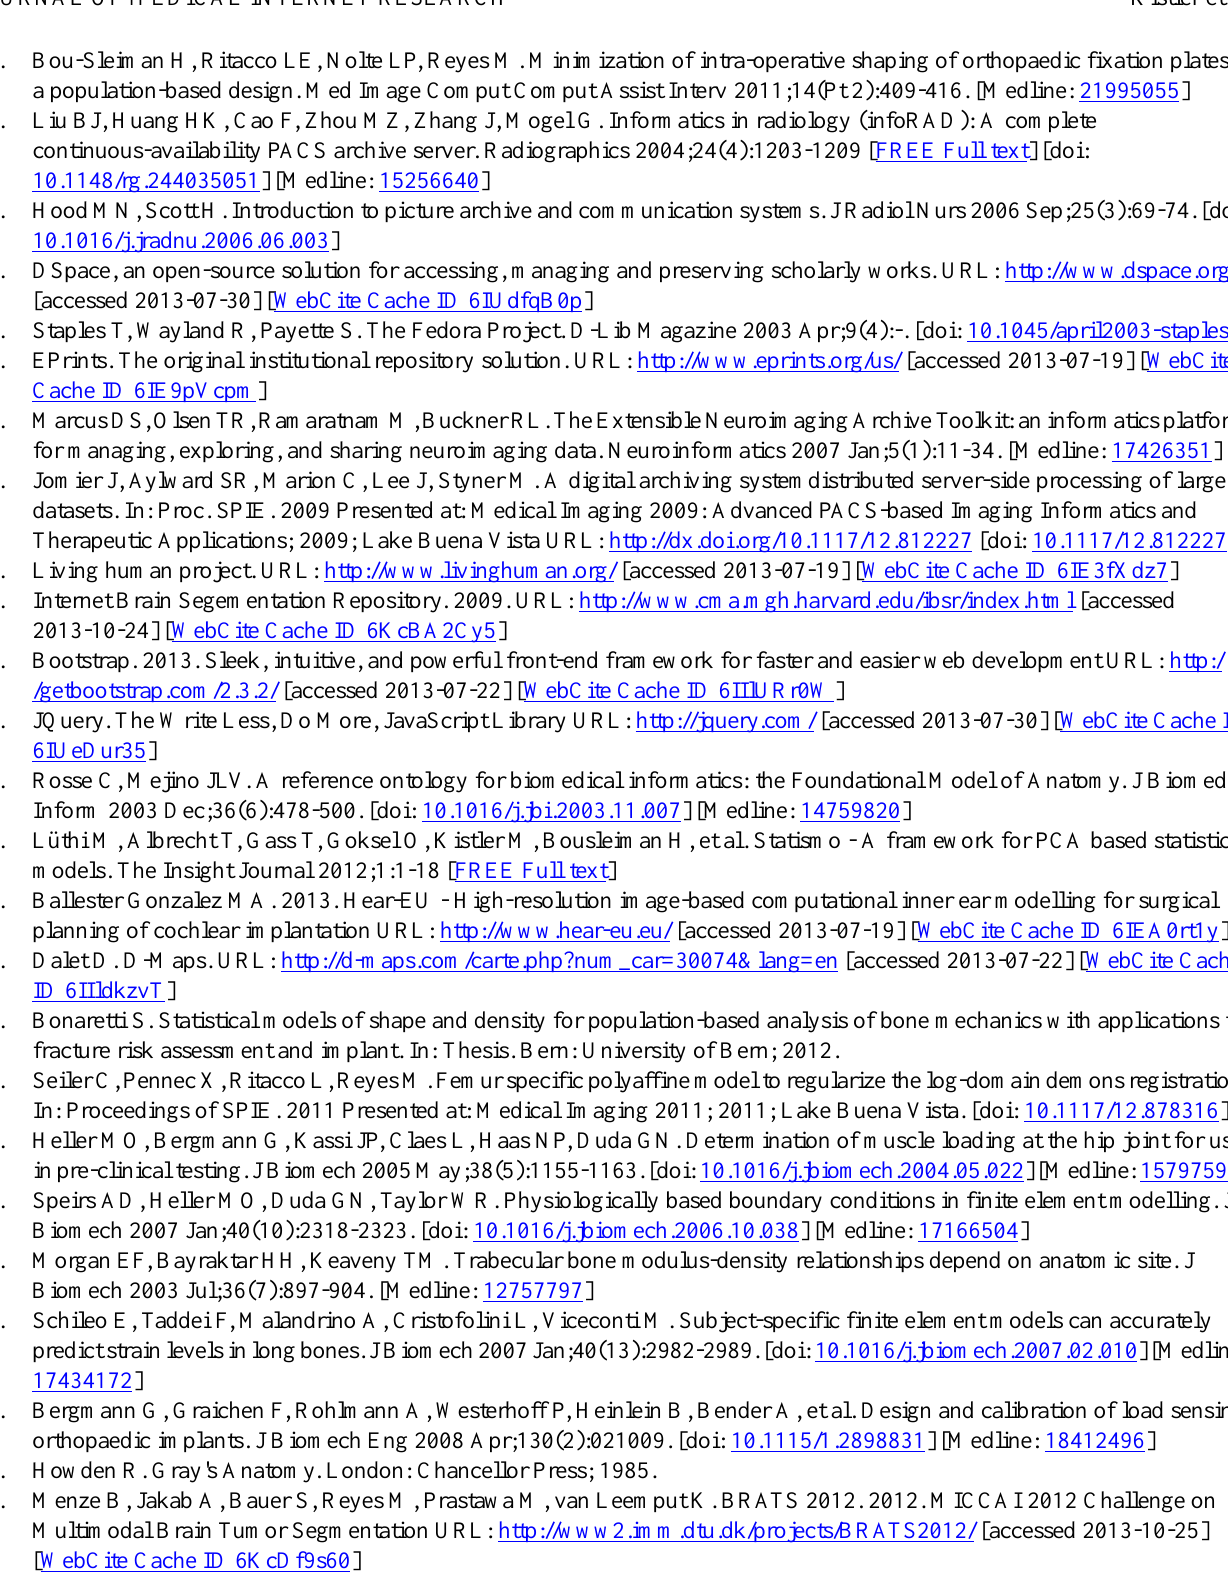
Abbreviations BRATS: Multimodal Brain Tumor Segmentation CSV: comma separated values CT: computed tomography DICOM: digital imaging and communications in medicine FMA: foundational model of